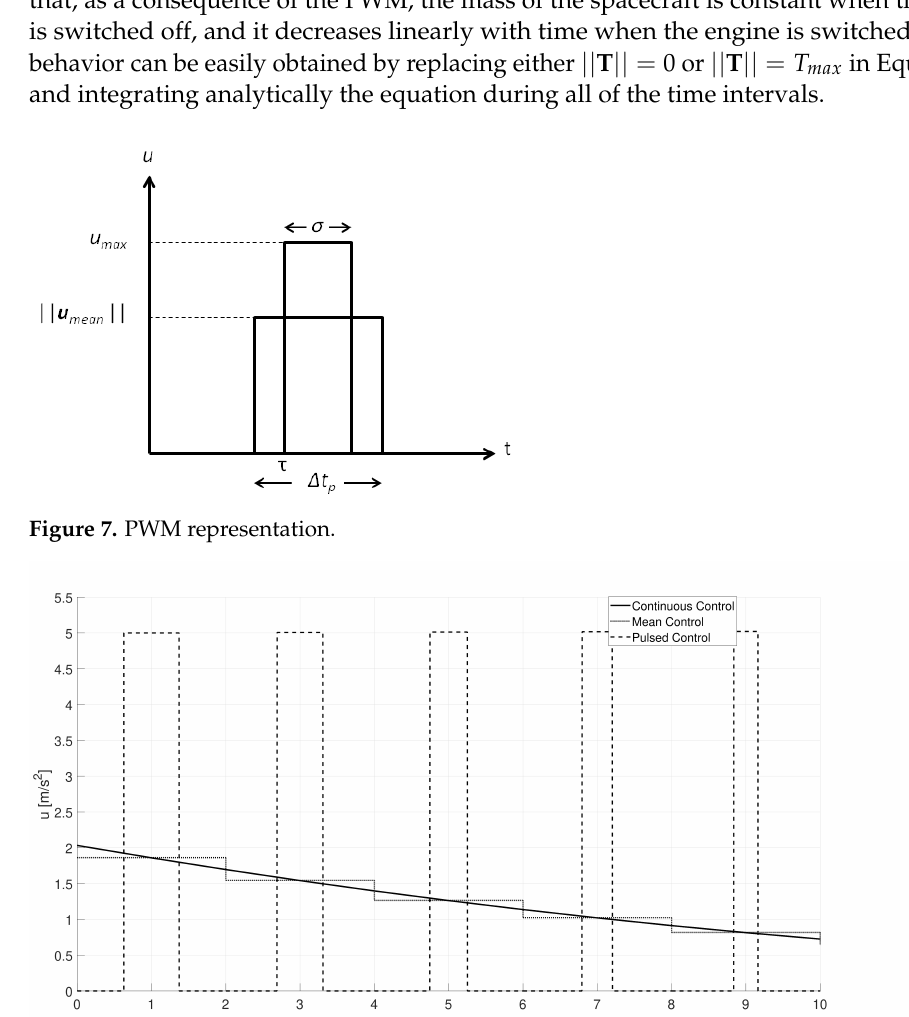
Figure 8. Continuous to pulsed control